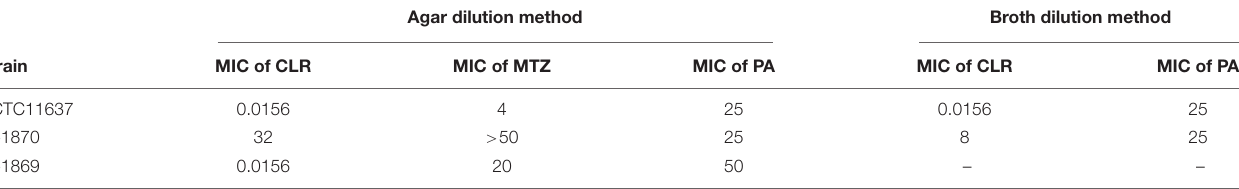
TABLE 1 | MICs for H. pylori a